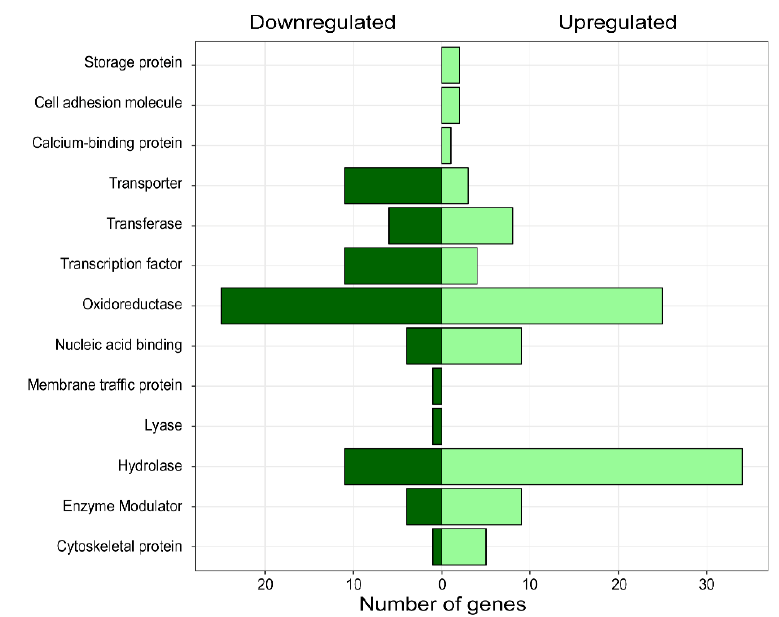
Figure 5. Distribution of differentially expressed genes according PHANTER classification system. The bars show the number of genes in each protein functional class. Genes are differentially expressed in treatment compared to control condition.